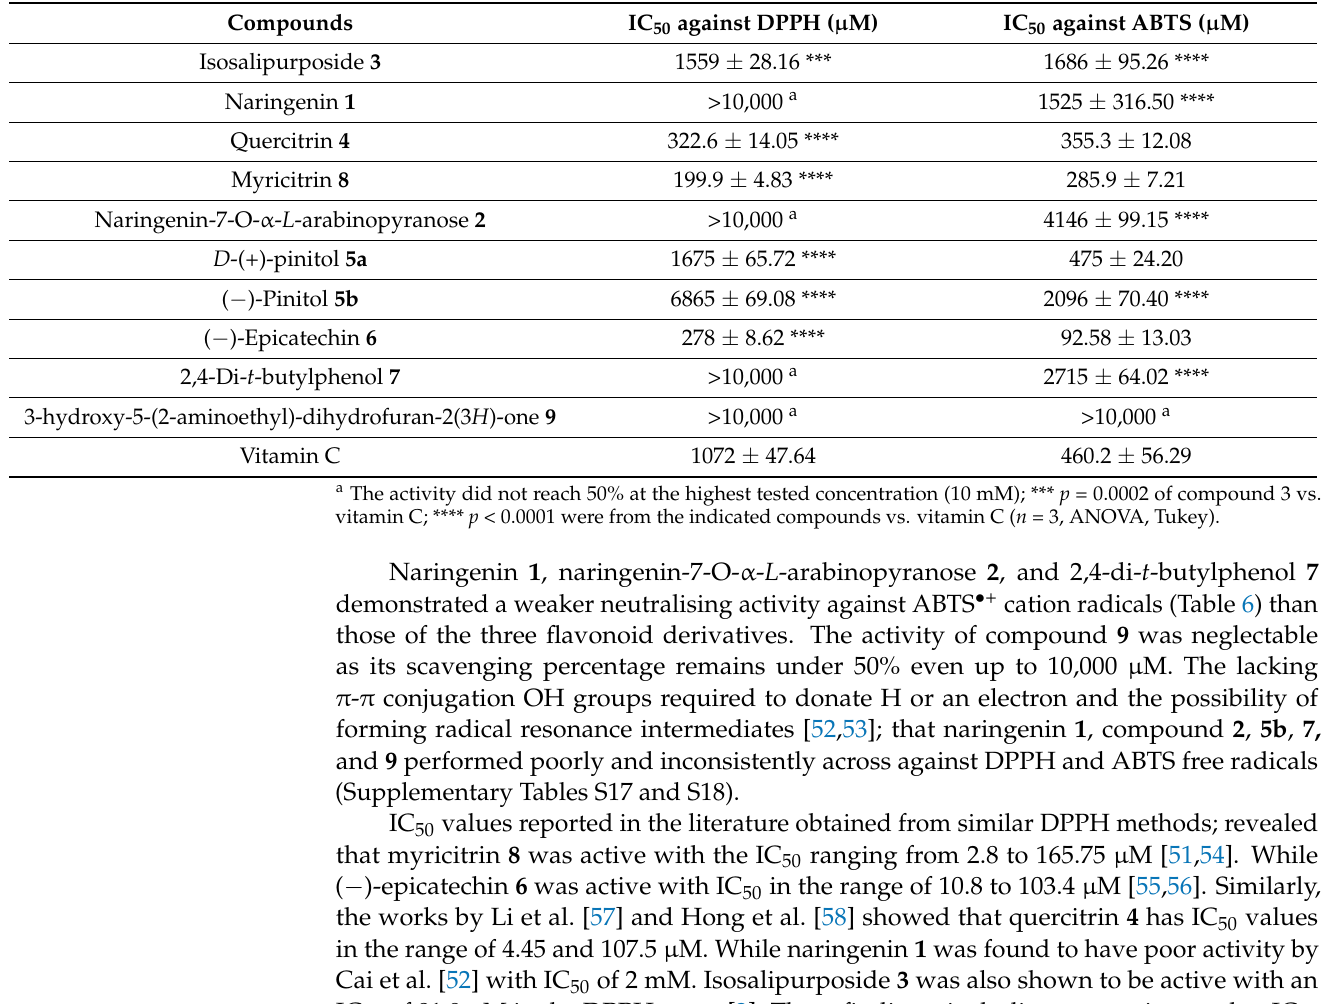
Table 6. The DPPH and ABTS scavenging properties of the isolated